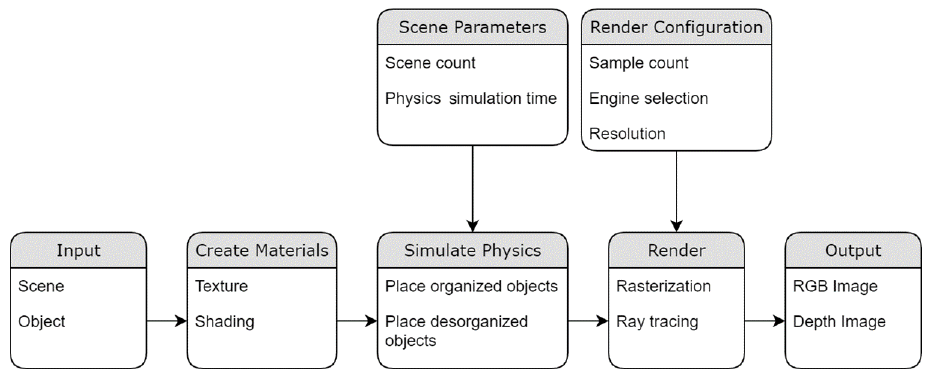
Figure 5. Pipeline diagram of rendering